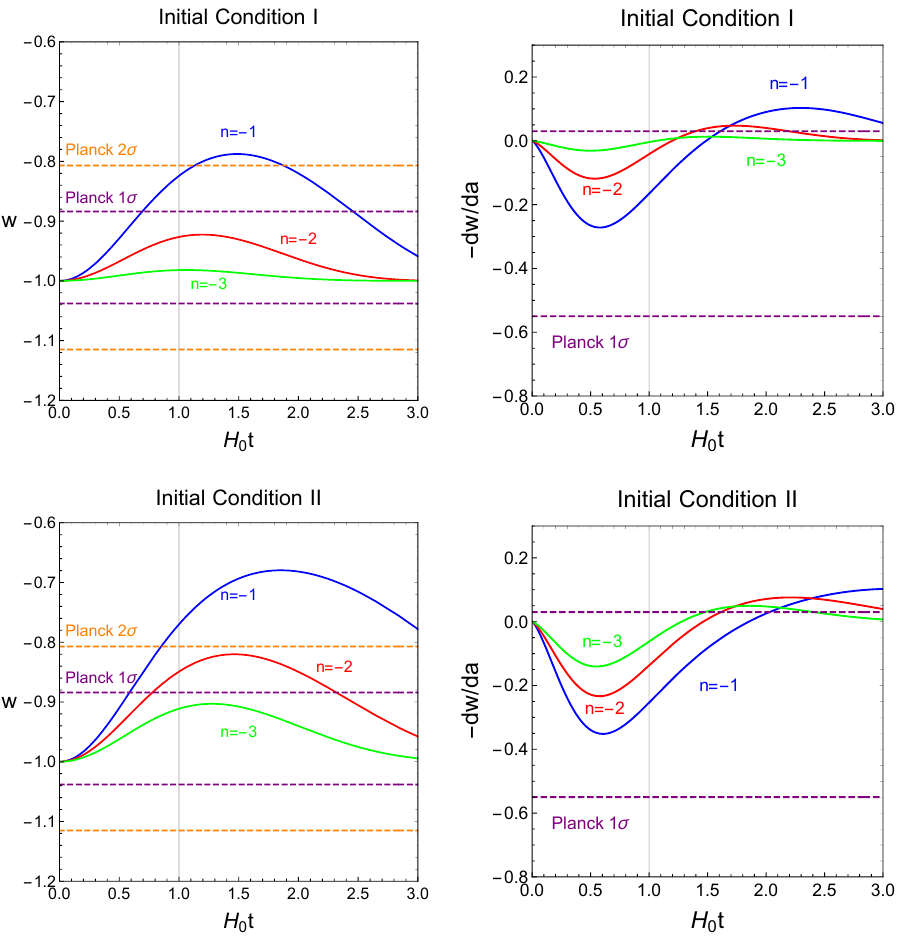
Figure 3 . Equation of state w and variation of equation of state, − dw/da , as functions of H 0 t . n = − 1 , − 2 , − 3 are taken in blue, red and green solid lines, respectively. We chose the initial conditions, φ i = − 2 M P , ˙ φ i = 0 for the upper panel, and φ i = − 2 . 5 M P , ˙ φ i = 0 for the lower panel. The vertical gray line is when a = 1 so H 0 t ’ 1